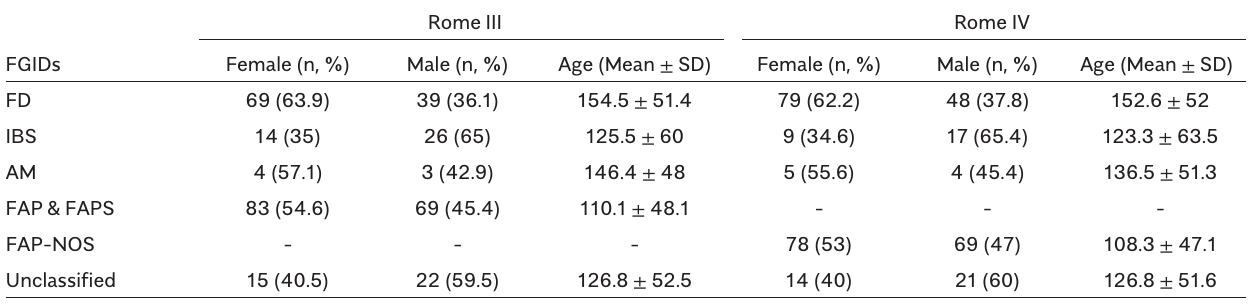
Table 2. Age and Sex Distribution of the Patients with Functional Gastrointestinal Disorders According to Rome III and Rome IV Classifications